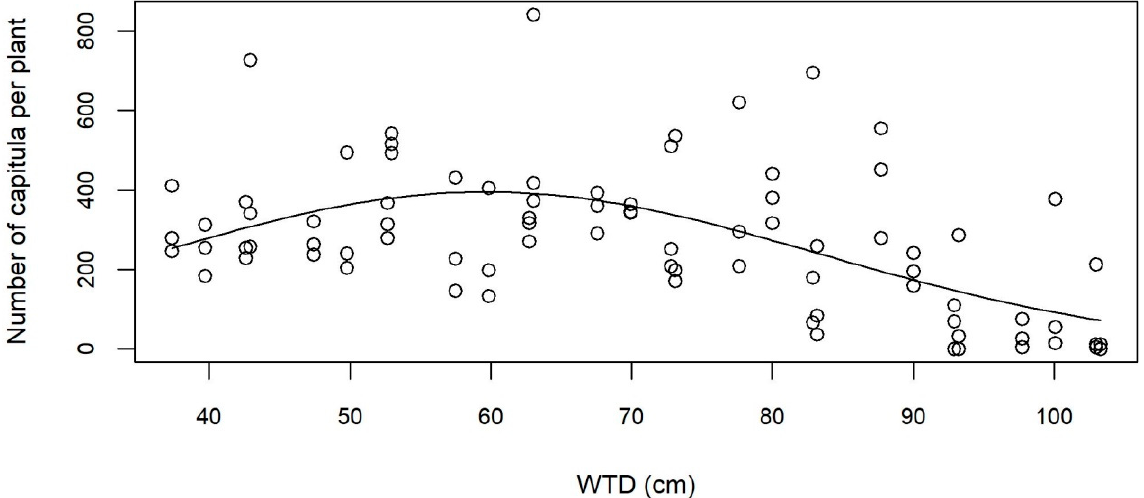
Figure 7. Number of capitula per plant of cup plant, regardless of their developmental stage, depending on water table distance (WTD). Data were collected at the end of the second growing season (September 2019). GLM: Poisson-distributed residuals, square function, p < 0.001, n = 84.